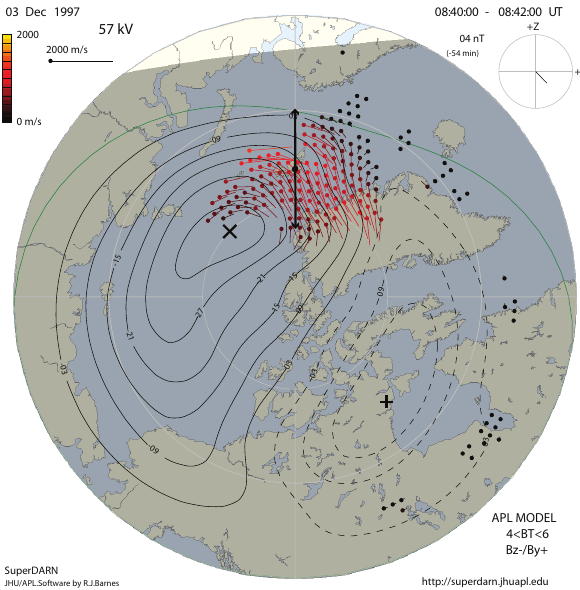
Fig. 8. SuperDARN convection data for 07:50–07:52UT. Ion drift vectors and convection streamlines are shown in MLT/MLAT co- ordinates. MSP FOV at 630.0nm is marked by double-arrowed meridional line. Ny ˚Alesund is marked by bold dot. 12:00MLT is at the top. The perspective is looking down on the polar atmosphere with the magnetic pole in the center. Dawn is to the right.